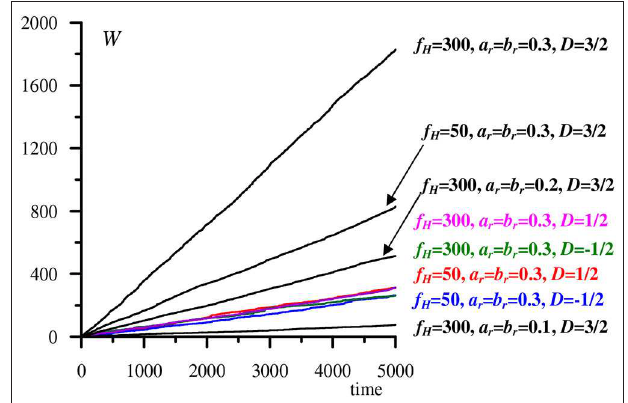
FIGURE 5 | Dissipated energy W as a function of time for different values of problems’ parameters. The curves are approximately linear which means that the average dissipated power P is constant.